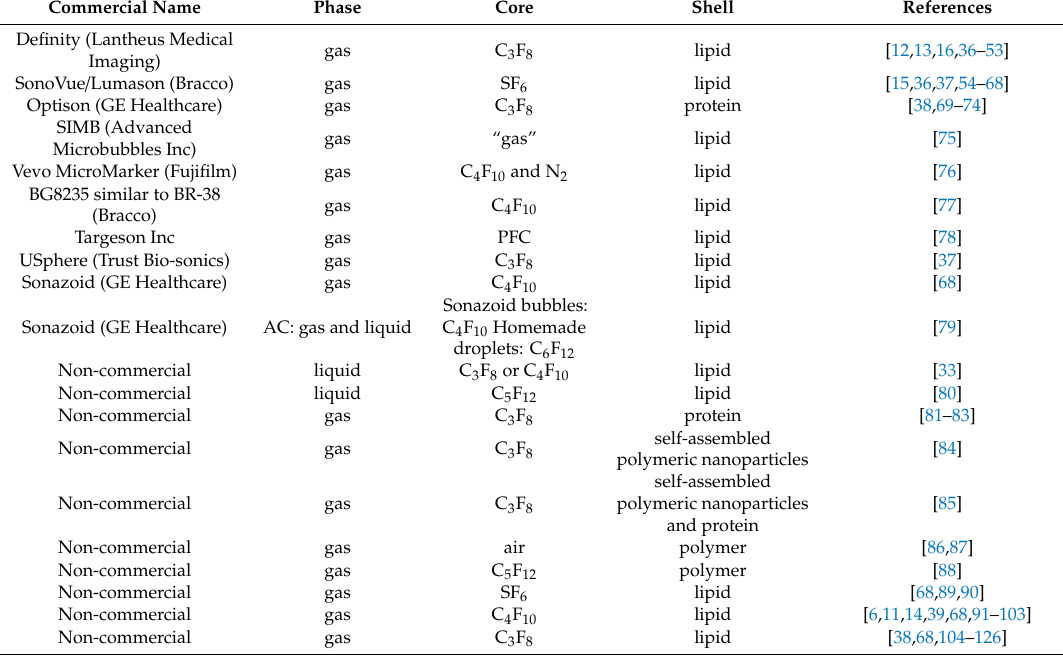
Table 1. Composition and phase of sono-sensitive agents used for BBB opening over the past 5